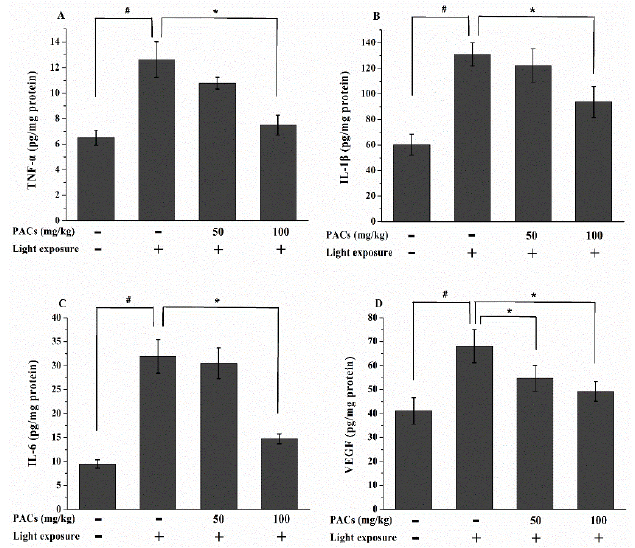
Figure 4. Changes in ( A ) TNF- α , ( B ) IL-1 β , ( C ) IL-6 and ( D ) VEGF levels in the retina 7 d after light exposure (18,000 lx). Data are expressed as the mean ˘ standard deviation ( n = 8). (#, ˚ ) p <